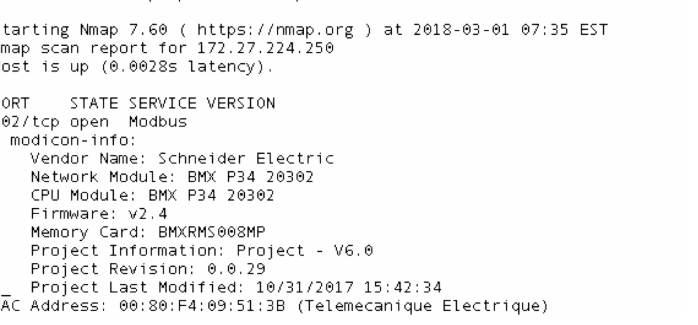
Figure 17. NMAP results for the modicon-info.nse script executed against the Schneider M340